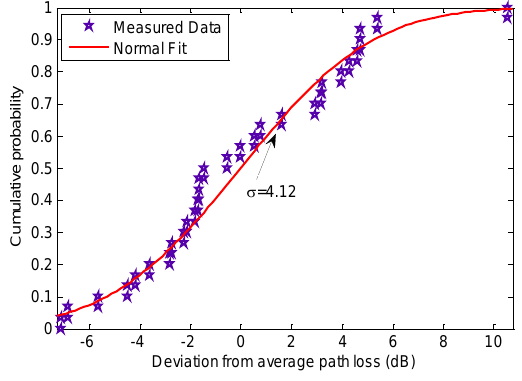
Figure 15. Deviation of measurement from the average path loss (fitted to normal distribution) of the dual band PIFA for off-body radio propagation channel at 1.9